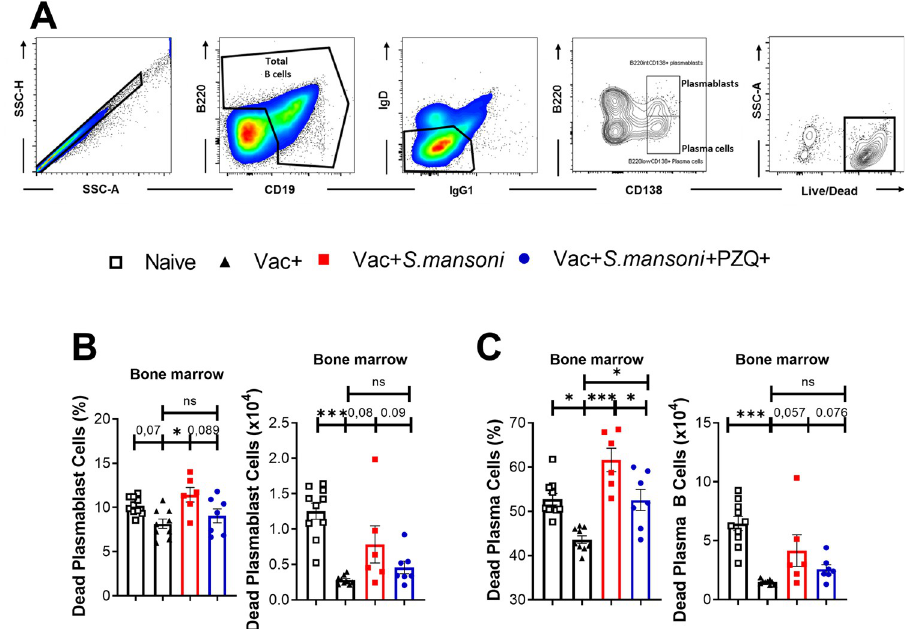
Fig 4. Cell death in CD138+ plasmablasts and plasma B cells from schistosomiasis-infected and anti-poliovirus vaccinated animals. (A) Representative gating strategy of dead cells among plasmablasts and plasma cells. (B) Dead plasmablast frequencies and absolute numbers in the bone marrow. (C) Dead plasma cell frequencies and absolute numbers in the spleen. Data are expressed as mean ± S.E.M and representative of 2 independent experiments (n = 6–10 mice per group in each experiment); Data analysed by Shapiro-Wilk test followed by either one way ANOVA with Bonferroni’s multiple comparisons test or by Kruskal Wallis followed by the Dunn’s multiple comparisons test; ns, p > 0.05; � p < 0.05, �� p < 0.001, ��� p < 0.0001; Vac, hexavalent (DTPa-hepB-IPV-Hib) vaccine; Sm, S . mansoni ; PZQ, praziquantel; SSC, Side scatter; FSC, forward scatter; CD19, cluster of differentiation 19; IgG1, Immunoglobulin G1; IgD, Immunoglobulin D; B220, B cell isoform of 220 kDa; CD138, cluster of differentiation